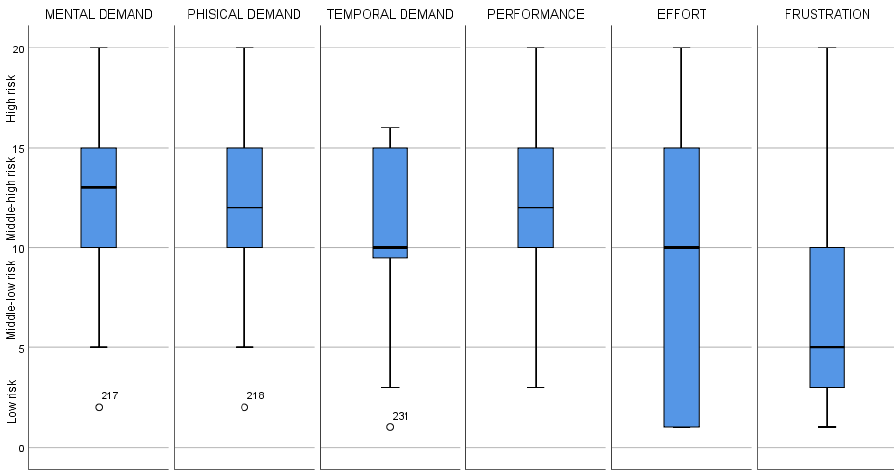
Figure 5. Comparison of the six NASA TLX parameters.